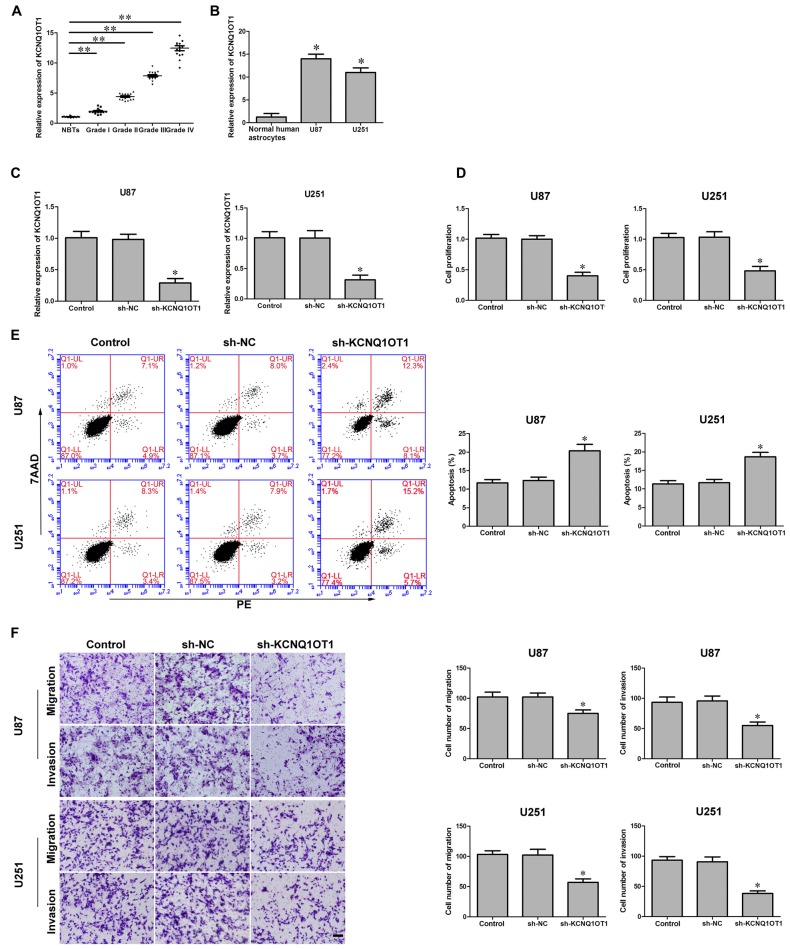
KCNQ1OT1 expression in glioma tissues and human glioma cells. Knockdown of KCNQ1OT1 restrained cell proliferation, promoted apoptosis and restrained migration and invasion in human glioma cells. (A) KCNQ1OT1 expression in normal brain tissues (NBTs), different grades of human glioma tissues. Data are presented as the mean ± standard deviation (SD; n = 15, each group). *P < 0.01 vs. NBTs group. (B) Expression levels of KCNQ1OT1 in human normal astrocytes and human glioma cell lines U87 and U251. Data are presented as the mean ± SD (n = 5, each group). *P < 0.01 vs. Normal human astrocytes (NHA) group. (C) Knockdown efficiency of KCNQ1OT1 inhibition. (D) CCK-8 assay was used to determine the proliferation effect of KCNQ1OT1 on human glioma cells. (E) Flow cytometry analysis of KCNQ1OT1 knockdown on glioma cells. (F) Quantification of migration and invasion of KCNQ1OT1 knockdown of human glioma cells. Representative images and accompanying statistical plots were presented. Data are presented as the mean ± SD (n = 5, each group). *P < 0.05 vs. sh-NC group. Scale bars represent 20 μm. **P < 0.01 vs. NBTs group.